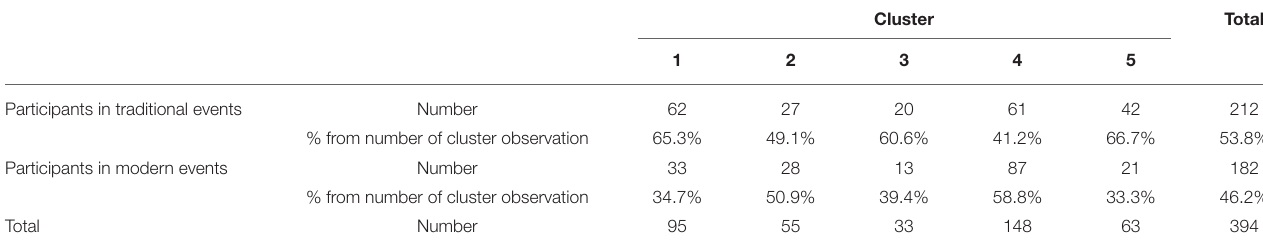
TABLE 13 | The number of participants based on the type of sport event.